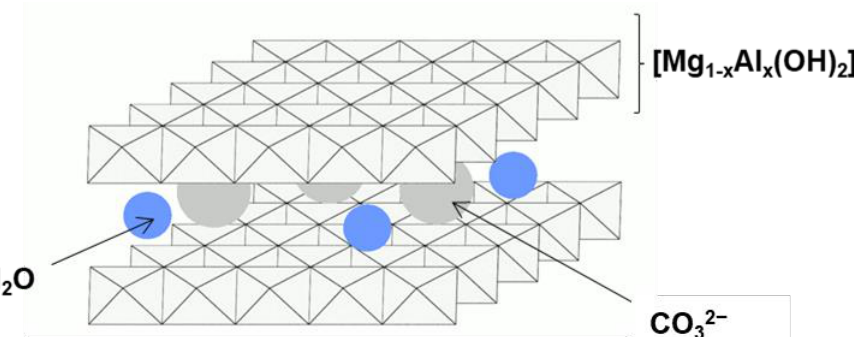
Figure 1. Schematic illustration of HT structure.